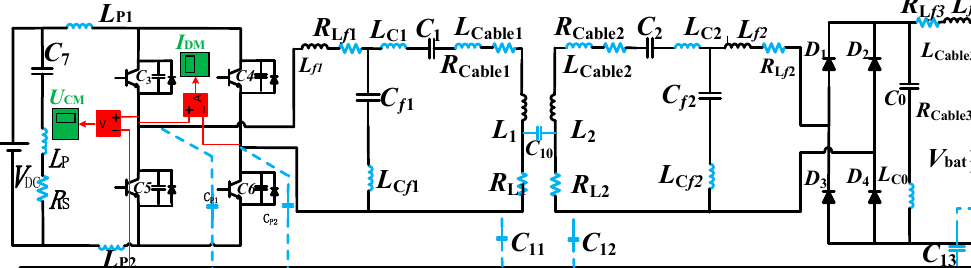
Figure 7. Equivalent circuit for EMI emission.